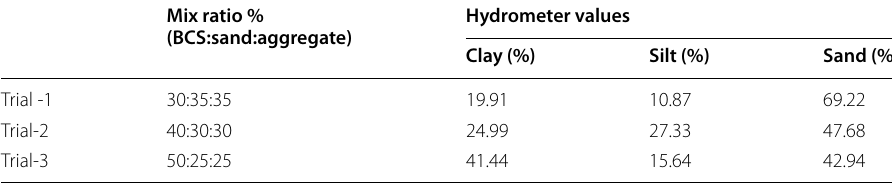
BCS black cotton